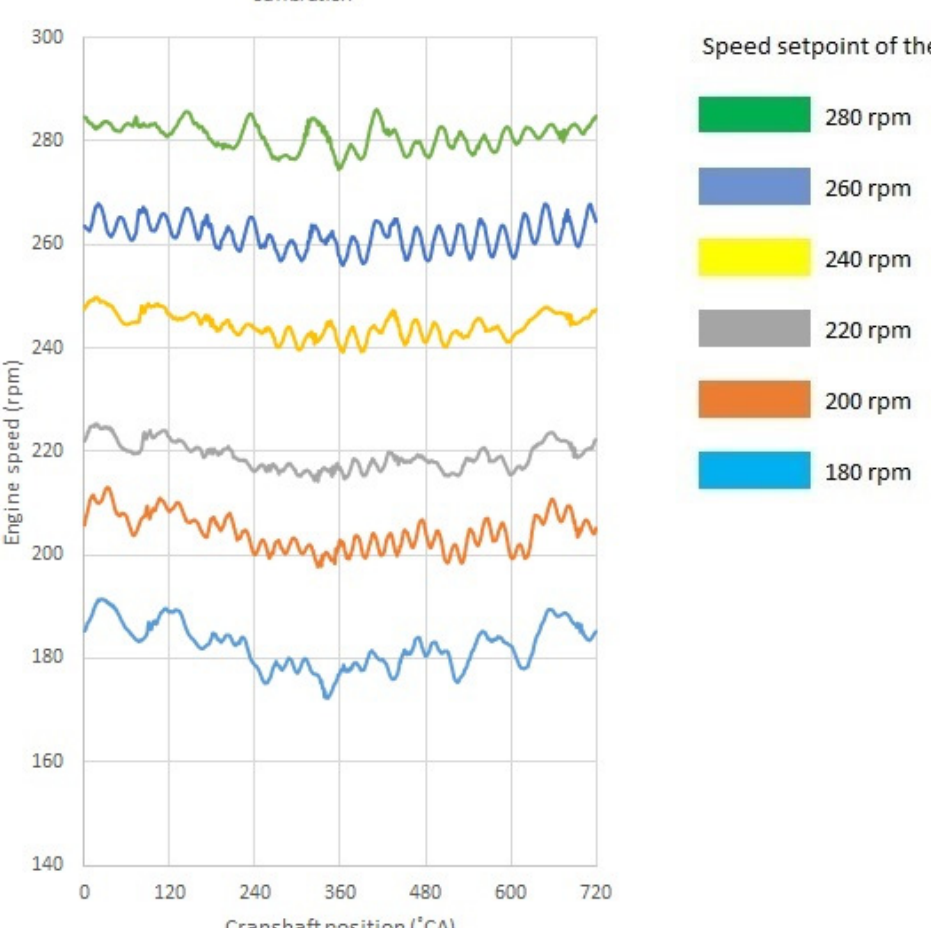
Figure 12. Reference measurements for a Buckau-Wolf R8DV-136 engine speeds from 180–280 rpm.